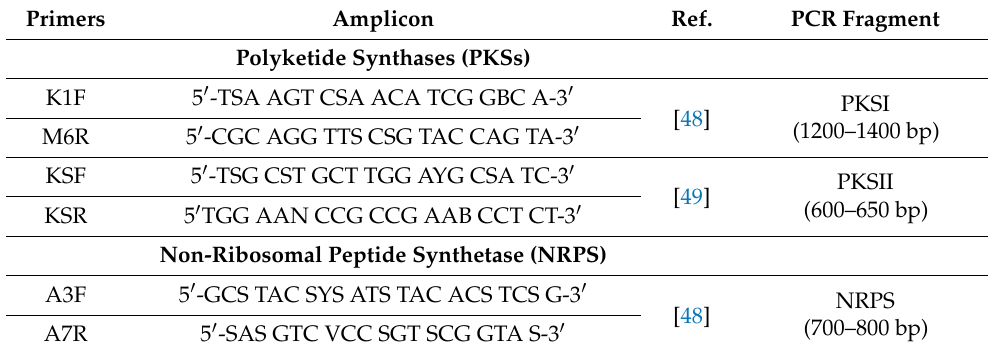
Table 3. Sets of degenerate primers for PKSs and NRPS detection in Actinobacteria. Degenerated nucleotides following the International Union of Pure and Applied Chemistry (IUPAC) nucleotide code are